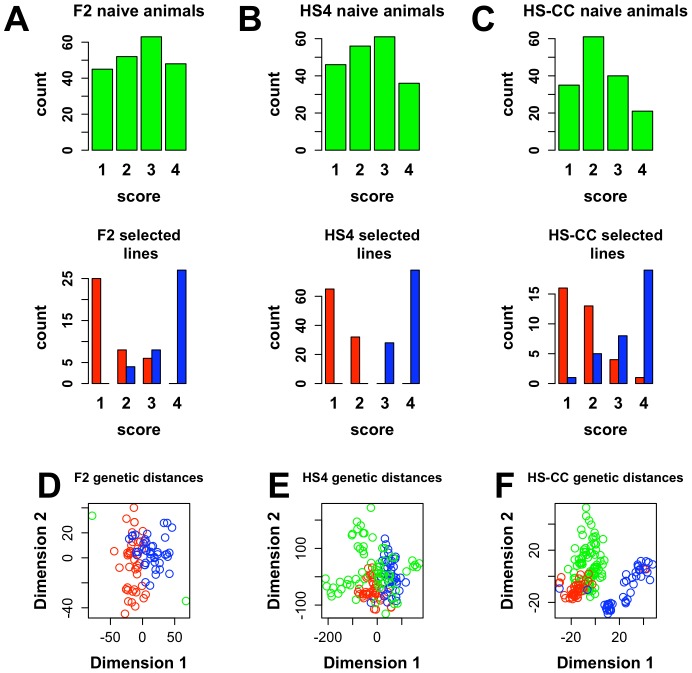
Phenotypic and genetic differences between naïve animals and selected lines.“Green”, naïve animals; blue, High line; red, Low line. A–C: Top, distribution of catalepsy responses in the naïve populations—high scores denote responders. Bottom, distribution of catalepsy responses in the selected lines. The three selected populations display differences in scores, showing successful selection. D–F: Multidimensional scaling of the genetic distances between individuals. The selected populations appear distinct from each other and closer together due to allele loss/fixation.